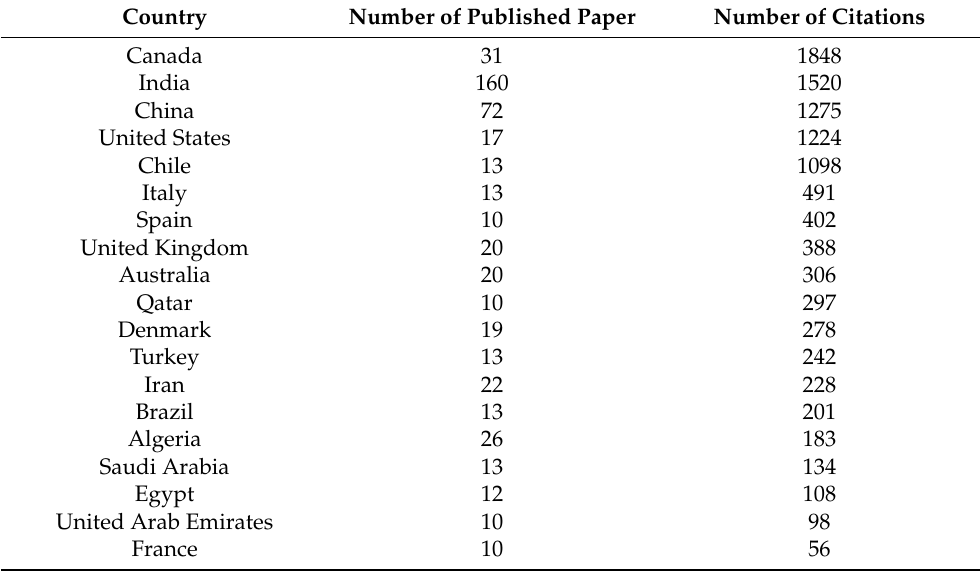
Figure 1. Number of published papers relating MLIS for grid-tied system applications (2012–2022). Table 1. Comparison of published papers and citations of MLIs Application on grid-tied system.